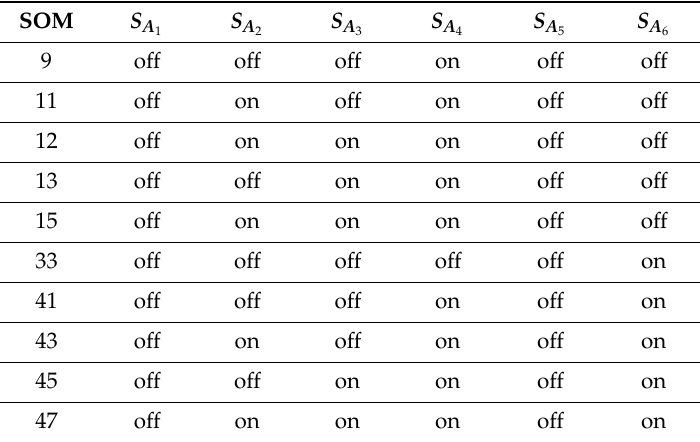
Table 2. Occurring system operation